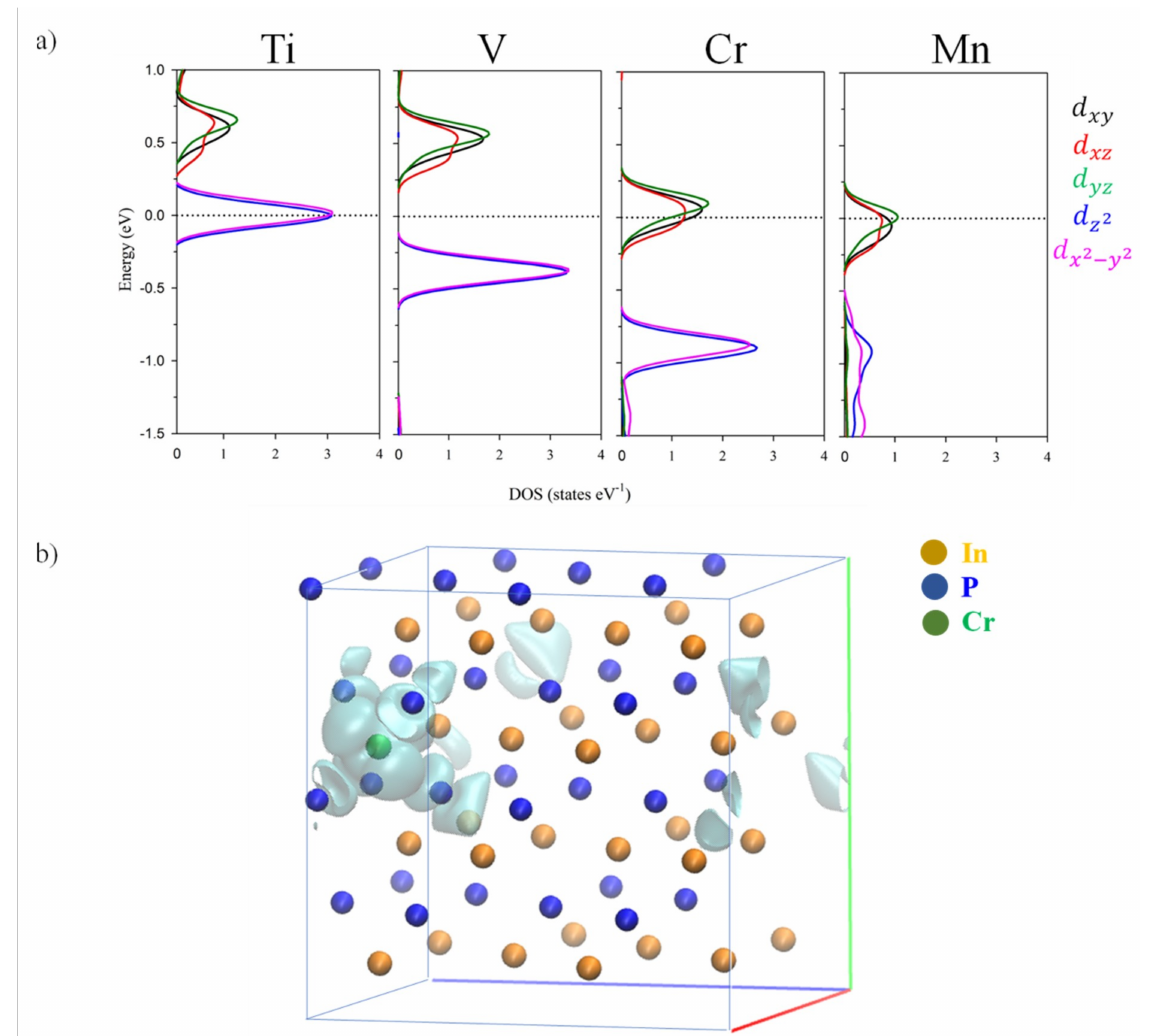
Figure 6. ( a ) Projected density of states of TM@InP showing the contribution of TM 3d-orbitals. The zero energy was set at the Fermi level (black dotted line); ( b ) the partial charge density of the intermediate band state for